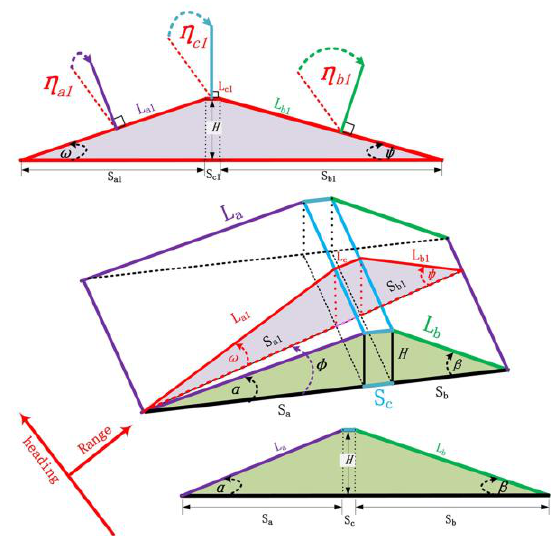
Figure 2. The dam transverse section along the radar range direction.